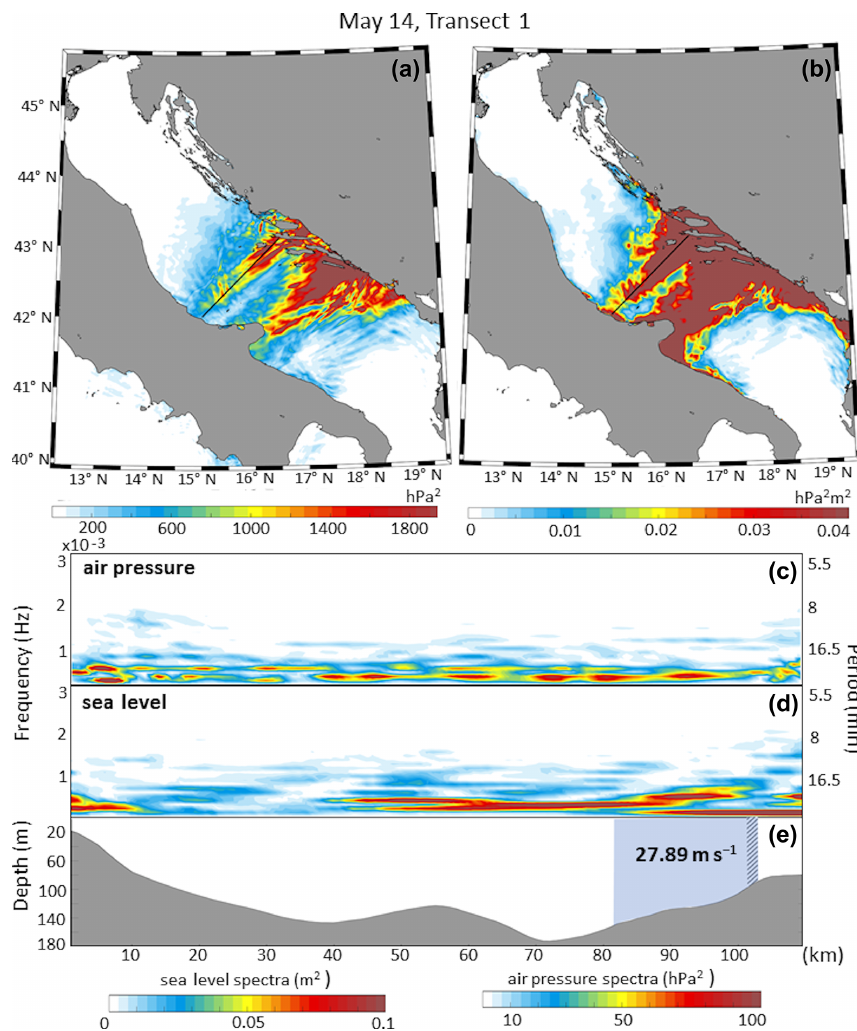
Figure 8. As in Fig. 7, but for the meteotsunamigenic disturbance of 14 May 2020 along Transect 1.